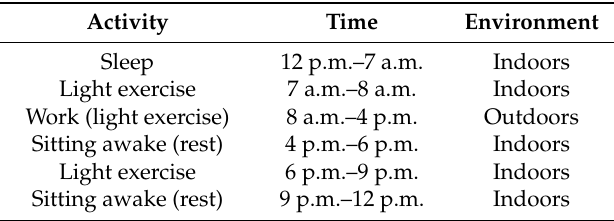
Table 2. Daily activity profile used in